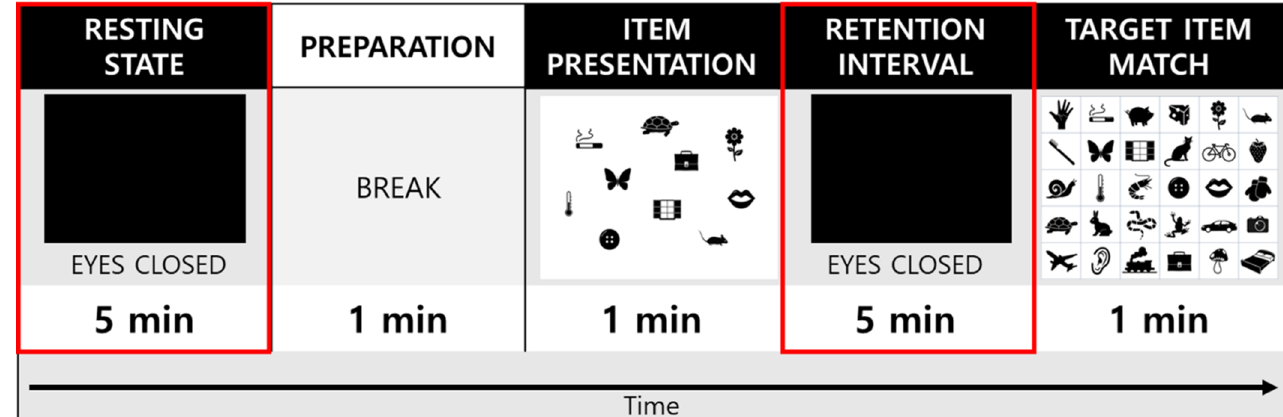
Figure 1. A schematic of the eyes-closed resting electroencephalography (EEG) and memory test protocol. The resting-state and retention interval (red squares) were used for analysis in the study.